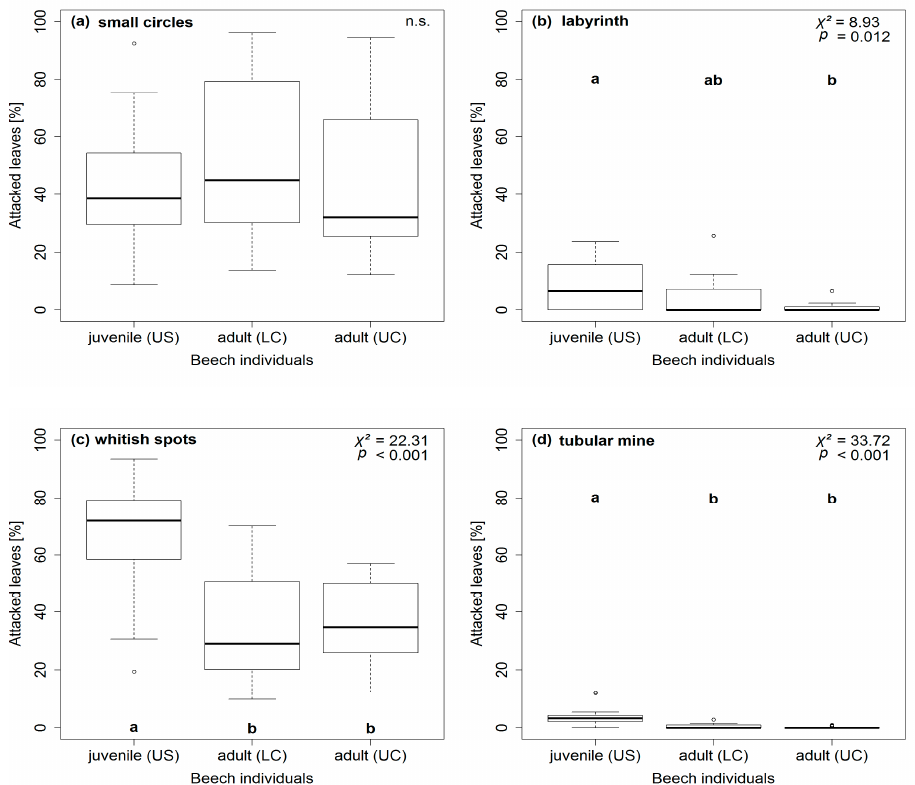
Figure 2. Distributions of herbivore attack levels for identified feeding traces along the vertical forest gradient. Percentages of attacked leaves on juvenile (US = understorey) and adult (LC = lower canopy, UC = upper canopy) Fagus sylvatica ( n = 60) are presented for the leaf-chewing feeding guild ( a ) small circles; ( b ) labyrinth; the sap-sucking feeding guild ( c ) whitish spots; and the leaf-mining feeding guild ( d ) tubular mine. Boxplots are marked with lowercase letters indicating significant differences using Kruskal-Wallis and post-hoc test ( p ≤ 0.05; df = 2) or with “n.s.” for non-significant differences.